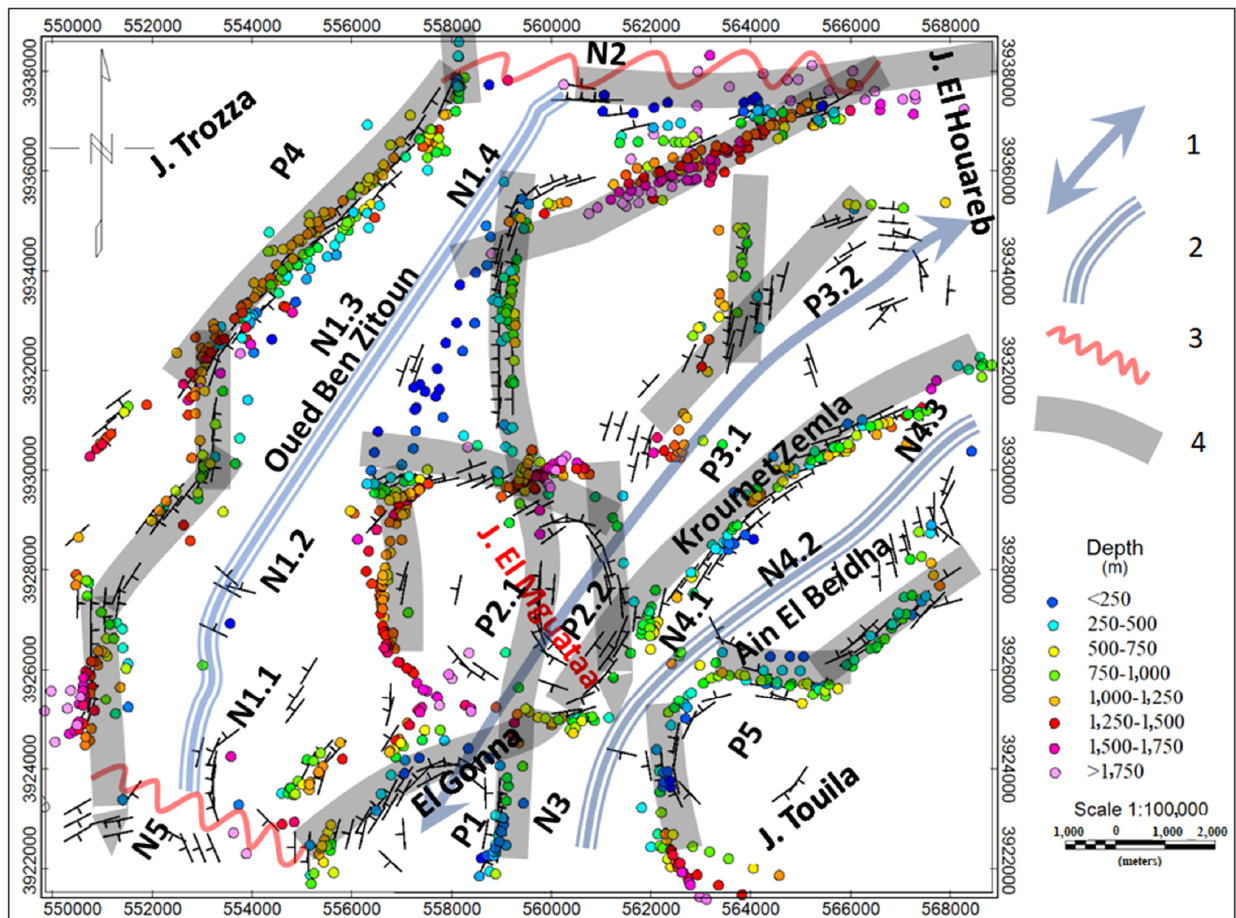
Figure 8. Detailed lineament map of the Ain El Beidha plain. deduced from the SED filter and Euler deconvolution solution results. Depth to source estimation was performed using a structural index of 0, a window size of 10*10, and a maximum percentage of depth tolerance of 15%. (1) Major positive gravity anomaly axis. (2) Major negative gravity anomaly axis. (3) Northern and southern limits of the Ain El Beidha plain. (4) Major fault/discontinuity corridors.